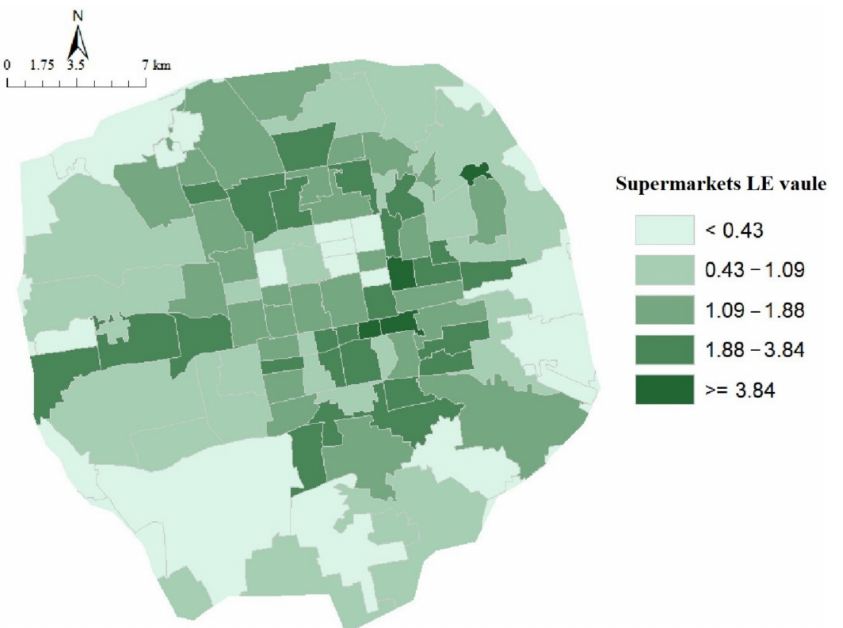
Figure 7. Distribution of the supermarket locational entropy values for streets within the Fifth Ring Road in